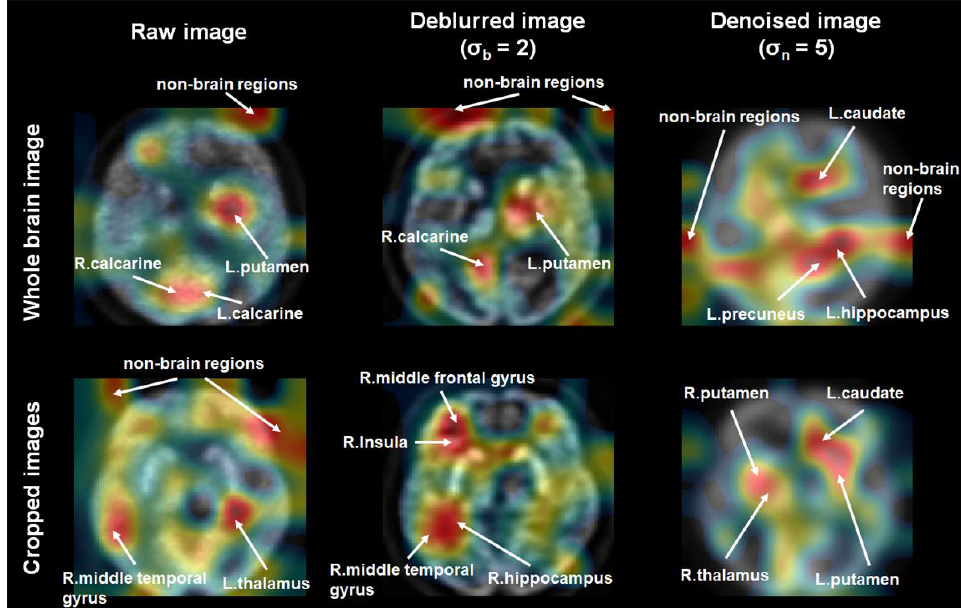
Figure 2. Activation maps showing brain regions learned by the 3D deep- convolutional neural network model as the most predictive of Alzheimer’s disease. Higher weights (red) indicate that the image intensity was more predictive of Alzheimer’s disease. Abbreviations: L, Left; R, Right.